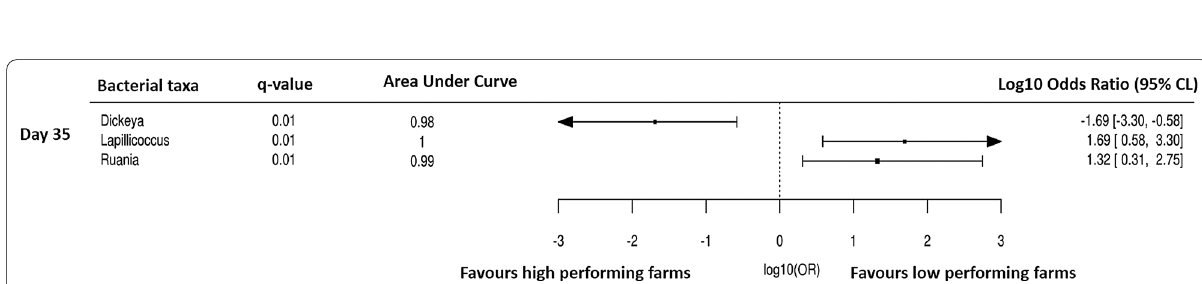
Fig. 7 Forest plot of the significantly different bacterial taxa (Wilcoxon q value < 0.05) of company B farms in dust with AUC left of the vertical dotted line (line of no effect) denote the increased chance of occurrence of microbiota towards high‑performing farm and the results to the right of the vertical dotted line denotes the increased chance of occurrence of microbiota towards low‑performing farm